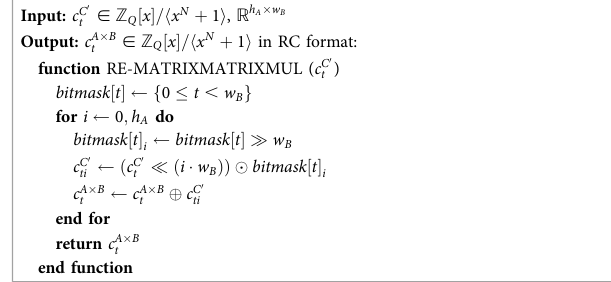
Algorithm 9 Result Extraction Matrix-Matrix